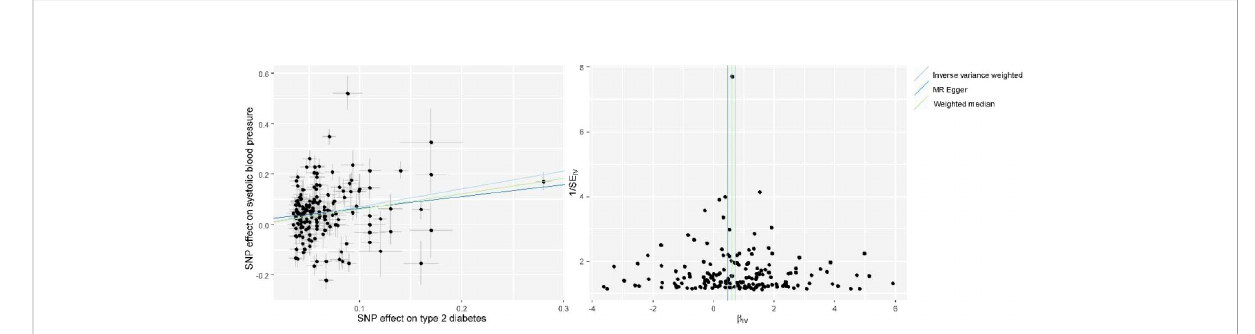
FIGURE 1 Scatter plot ( left ) and funnel plot ( right ) of Mendelian randomization (MR) analyses showing that T2DM is causally associated with increased systolic blood pressure (SBP). MR, Mendelian Randomization; SNP, single nucleotide polymorphism; IV, instrumental variable; T2DM, type 2 diabetes mellitus; SBP, systolic blood